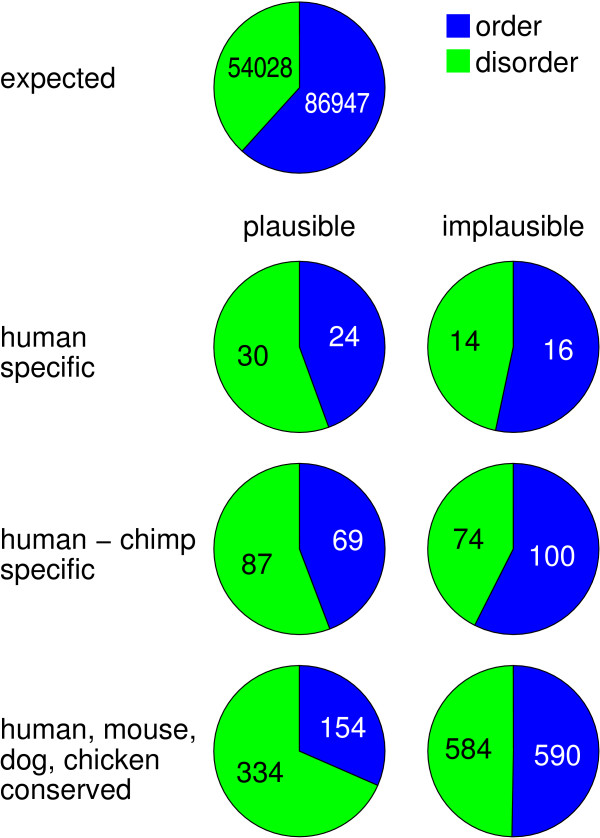
Distribution of evolutionary 'young' and 'old' plausible vs. implausible NAGNAG acceptors in ordered and disordered regions. The expected distribution is the overall number of introns in ordered/disordered regions.